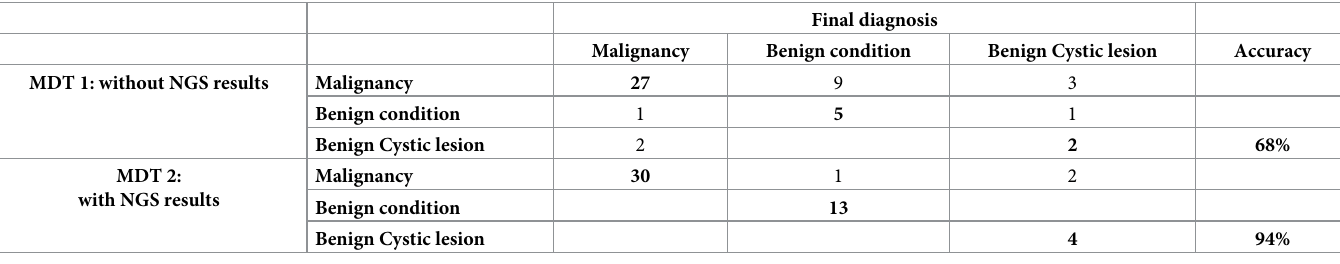
Table 2. Diagnosis with and without NGS results correlated to final